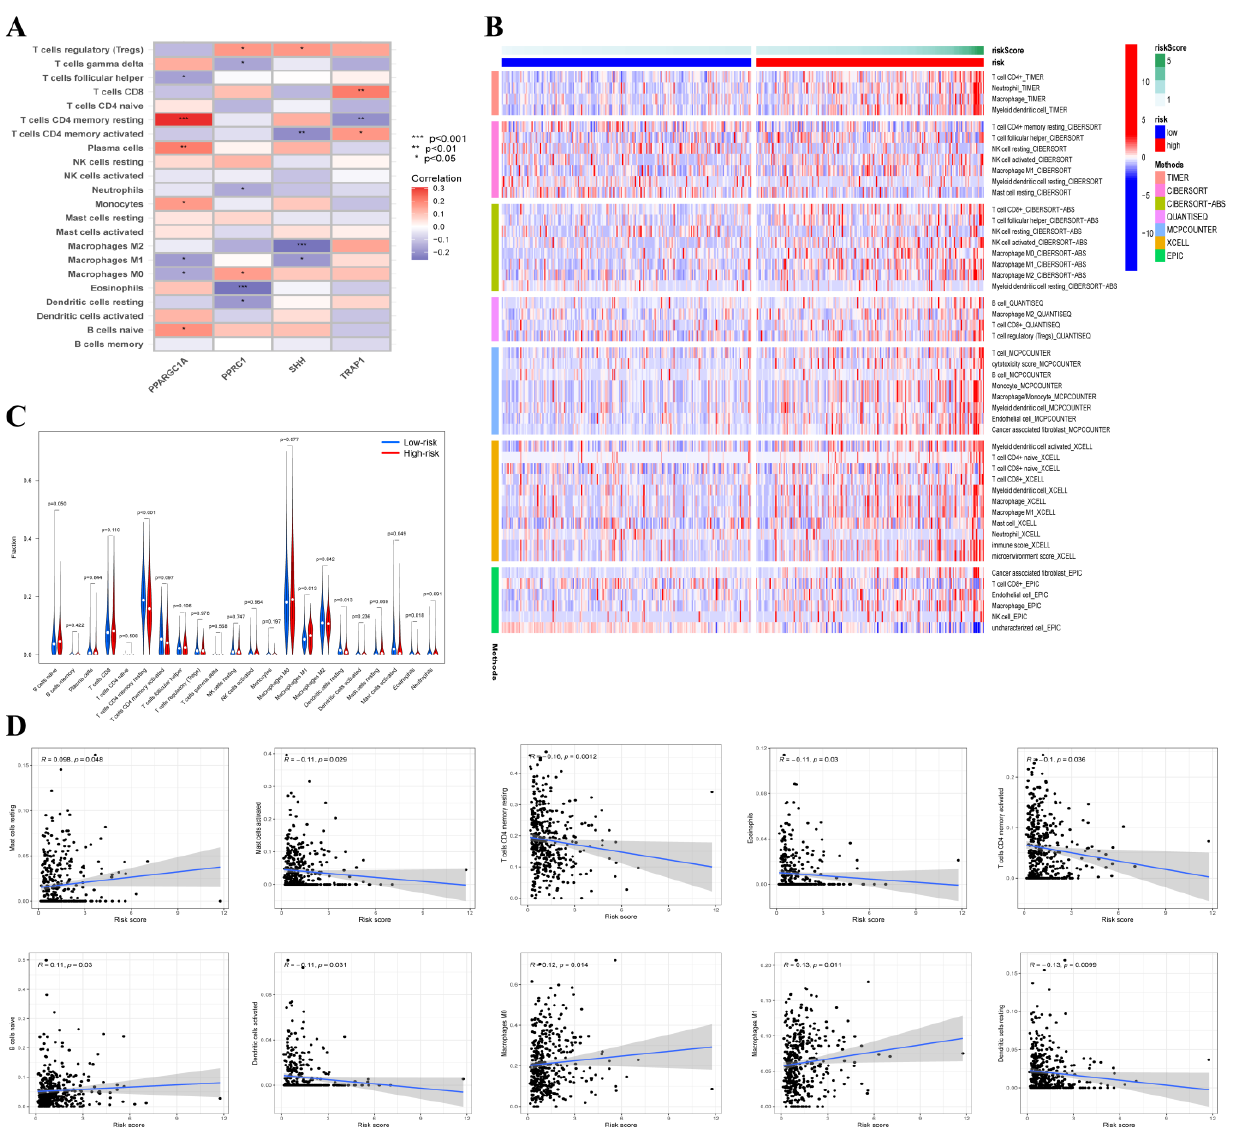
Figure 6. The correlation between risk score and tumor-infiltrating immune cell (TICs). ( A ) The relationship between four OXPHOS-related gene expression level and TICs. Red indicates positive correlation while blue indicates negative correlation. ( B ) The infiltration of 21 types of immune cells in high-risk and low-risk groups was estimated by TIMER, CIBERSORT, CIBERSORT-ABS, QUANTISEQ, MCPCOUNTER, XCELL and EPIC database. ( C ) Comparison of TICs in high-risk and low-risk groups. ( D ) The correlation between risk score and immune cells, and the results significant differences were shown.